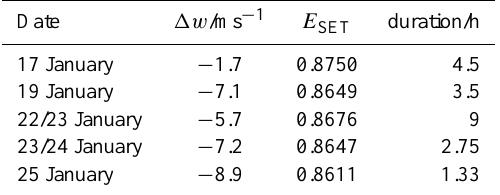
Table 2. Vertical pointing measurements with SET. Second column shows the apparent vertical wind speed between 50 and 60km alti- tude derived by internal calibration ( E SET =0.8776). Third column shows resulting E SET as calculated for zero vertical wind speed (at- mospheric